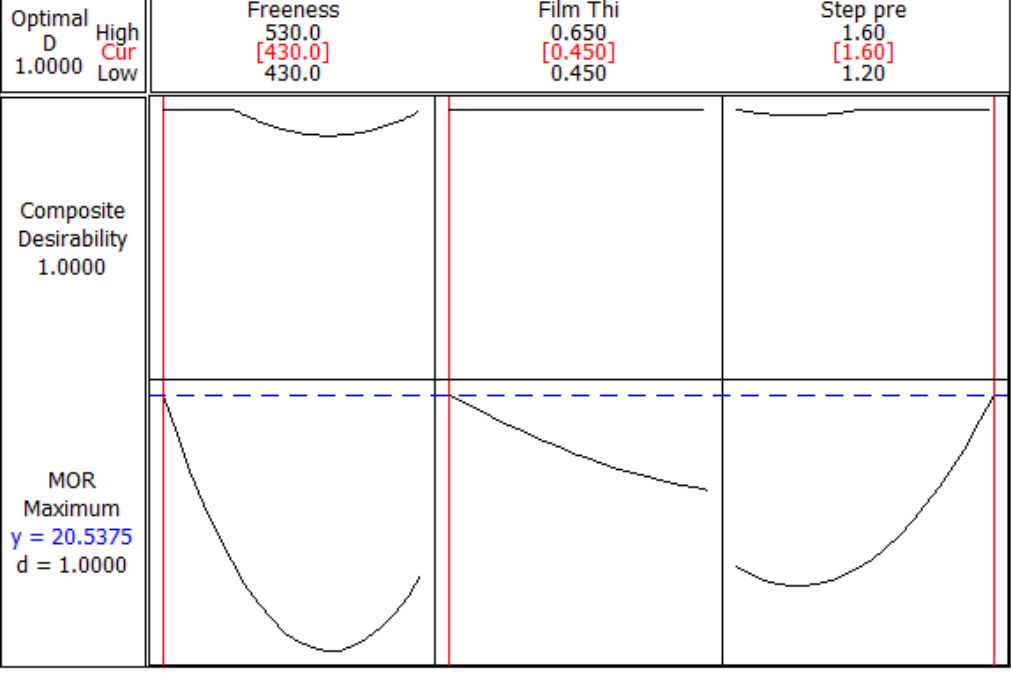
Fig. 5. The optimization